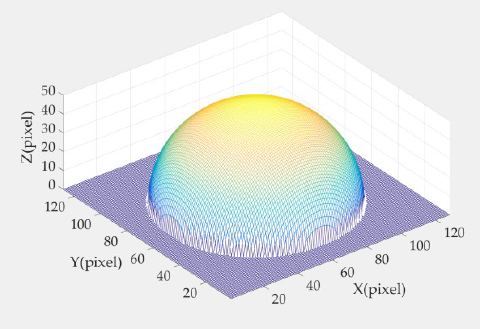
Figure 5. Composite hemisphere.